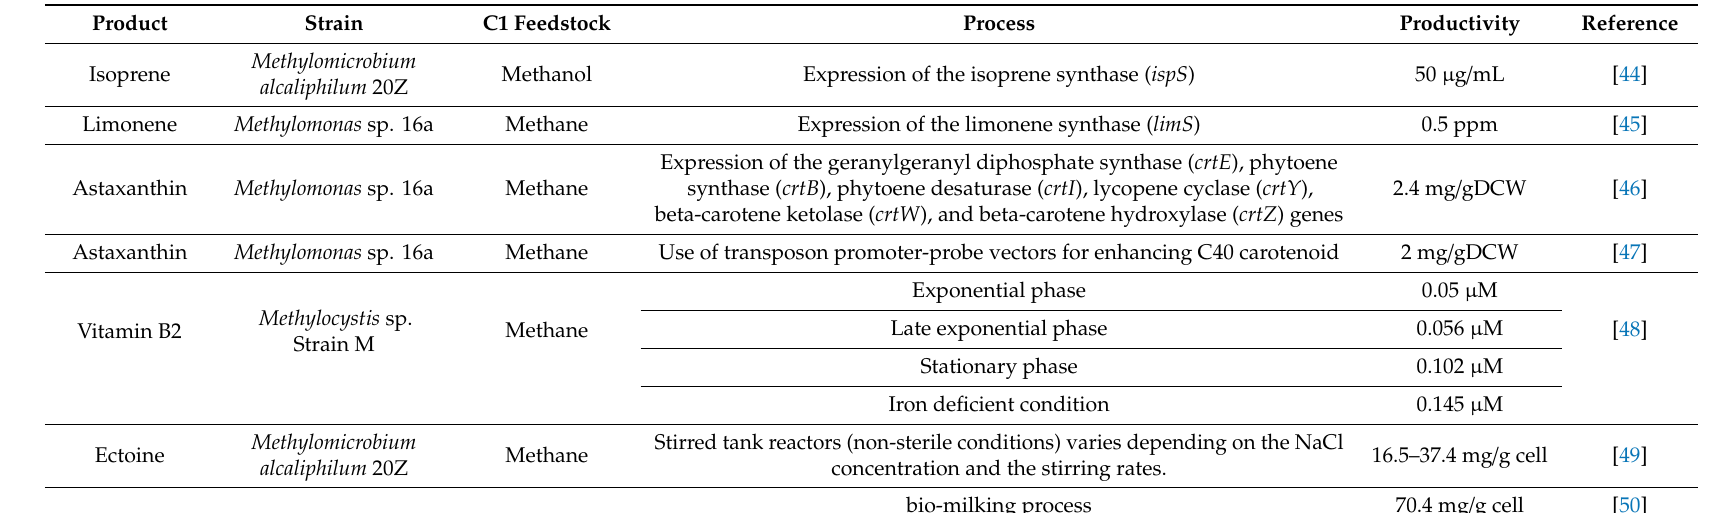
Table 2. Production processes and productivity of secondary metabolites by